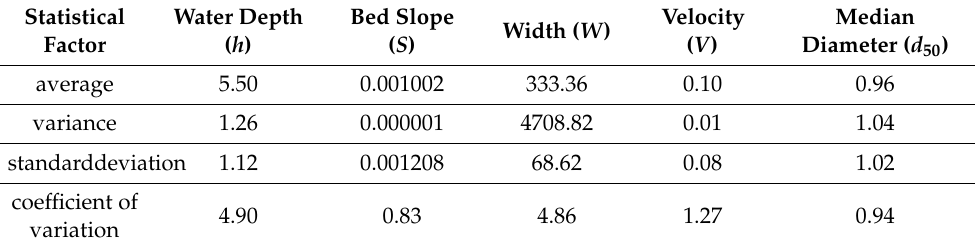
Table 10. Simple statistical analysis outcomes for explanatory variables for